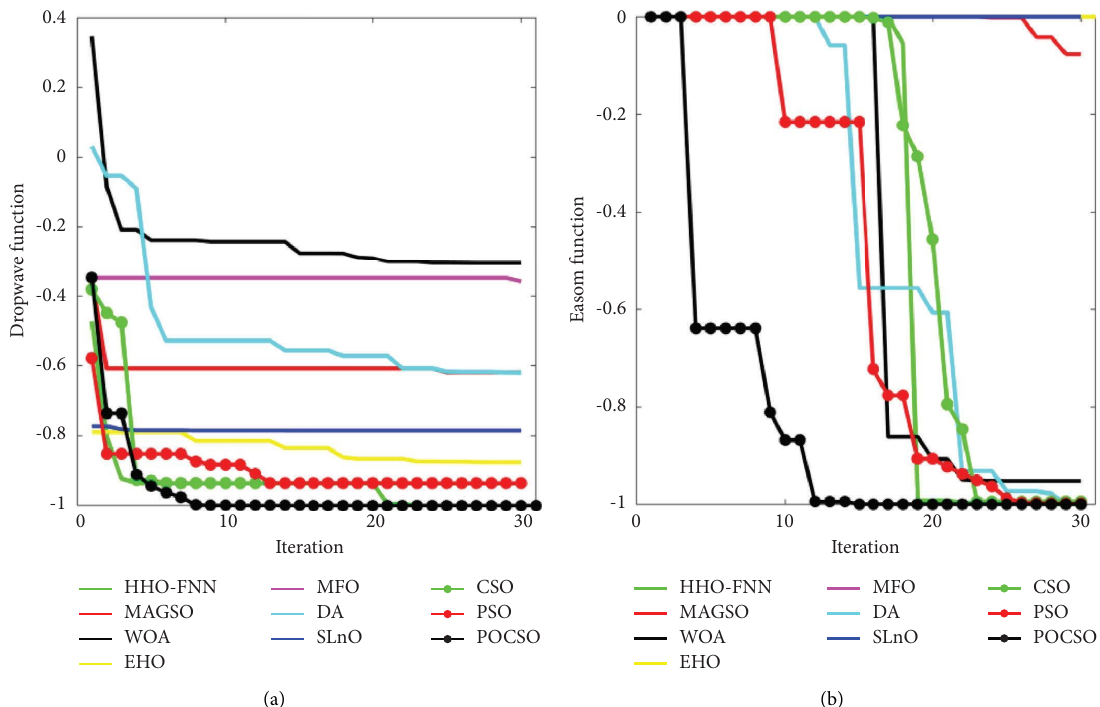
Figure 11: Convergence analysis of the proposed POCSO and extant methods for multimodal with fxed values benchmark functions such as (a) dropware and (b)